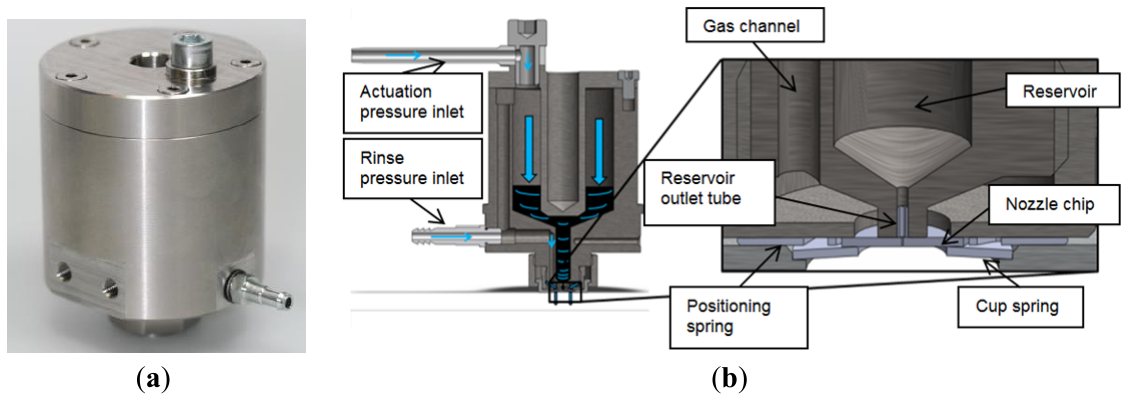
Figure 3. Enhanced StarJet actuator made from stainless steel ( a ). Model cross section view of the StarJet V2 and close-up of the chip mounting section ( b ); blue arrows indicate the pneumatic